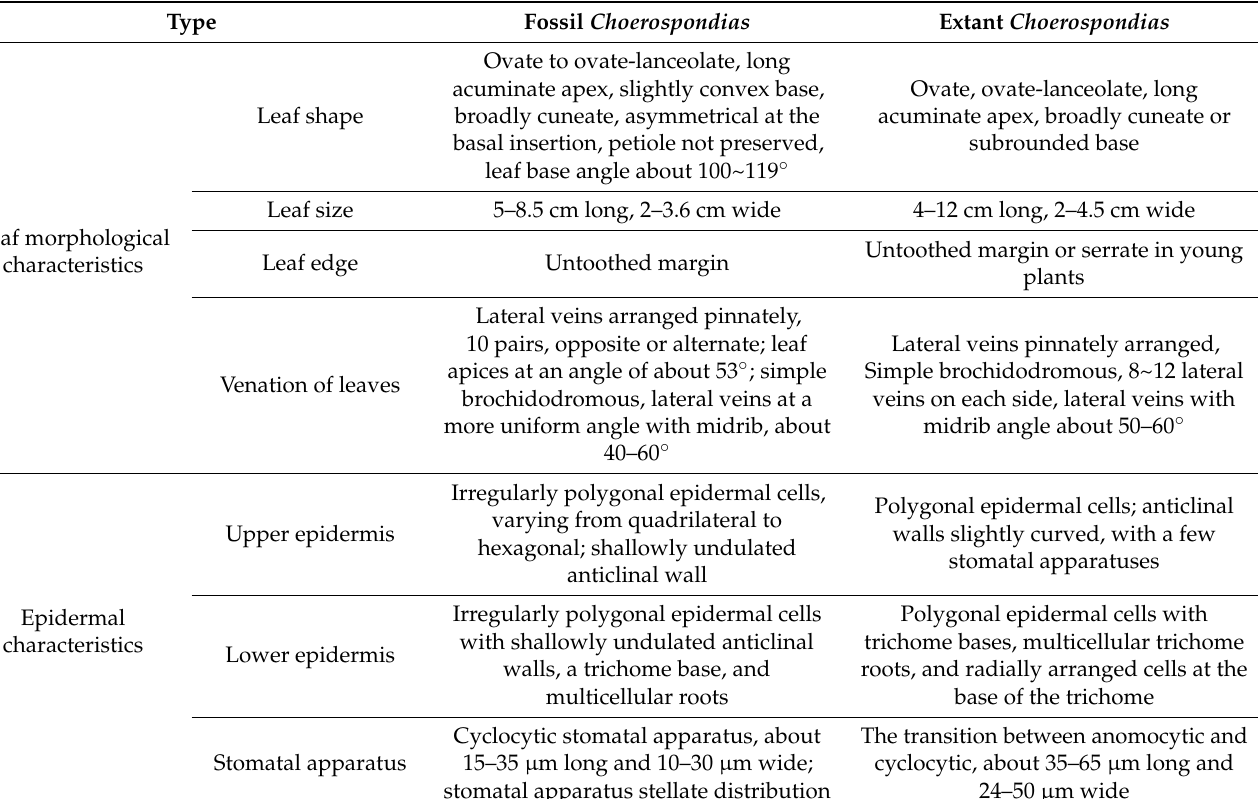
Table 2. Comparison of leaf architecture and cuticular features of fossil and extant Choerospondias